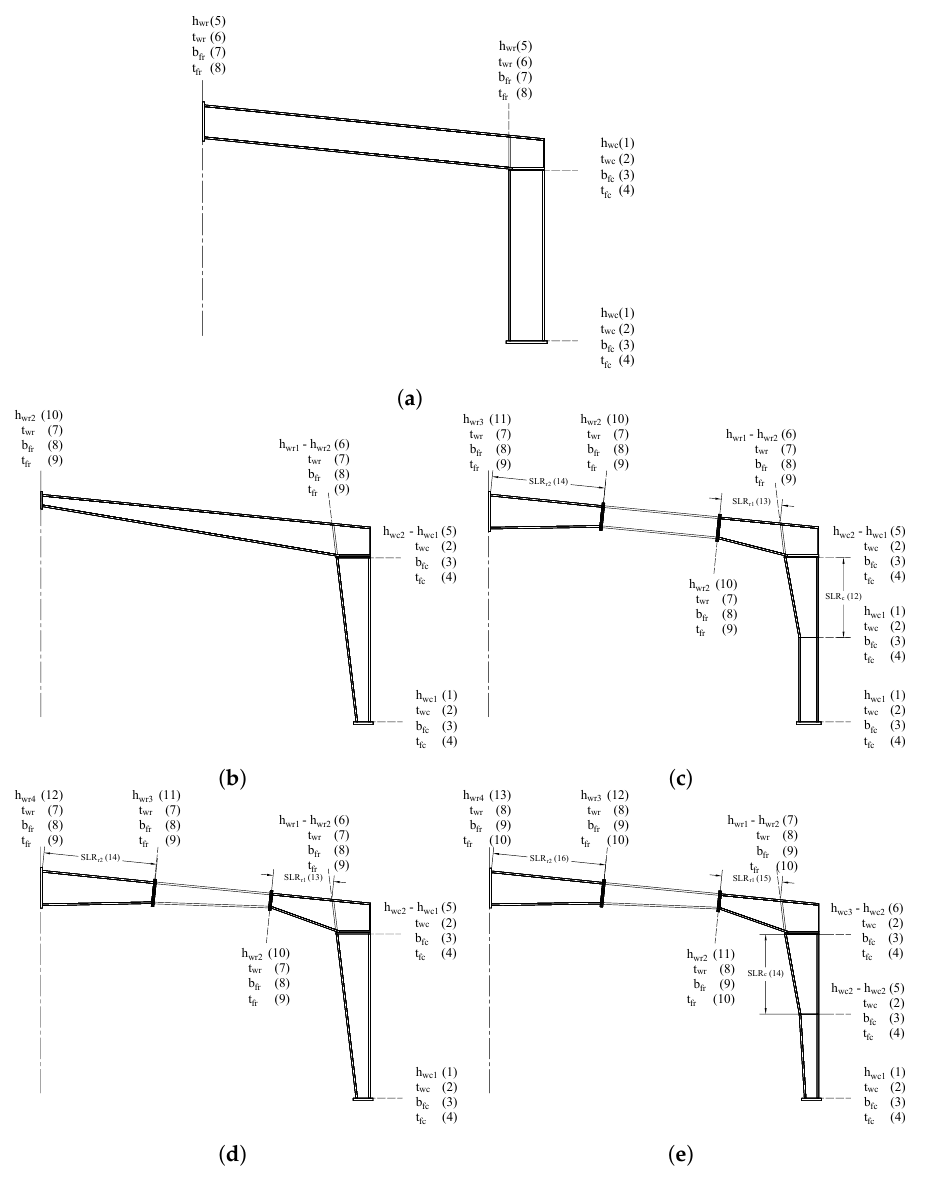
Figure 1. Utilized gable frame configurations and design variables: ( a ) control model; ( b ) Model 1; ( c ) Model 2; ( d ) Model 3; ( e ) Model 4. Table 1. Design variables discrete